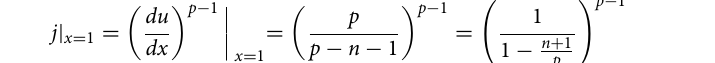
Figure 3. Profiles of dead-core solutions for φ p , n 0.5 ; ( b ) various reaction orders and fixed diffusion exponent p reaction order n =